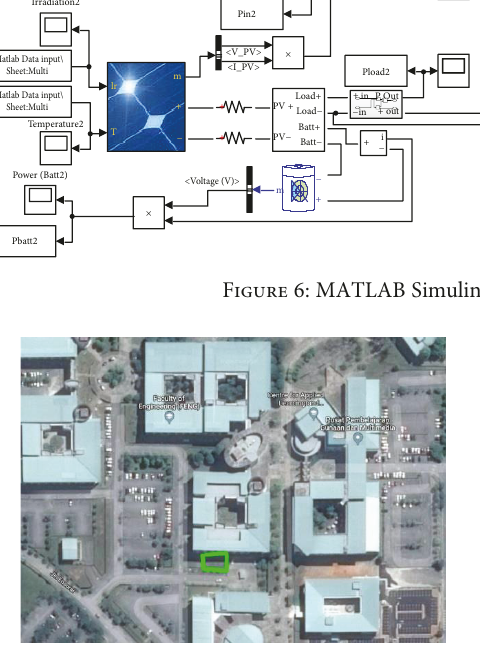
Figure 7: Location of the experimental work at UNIMAS as highlighted in